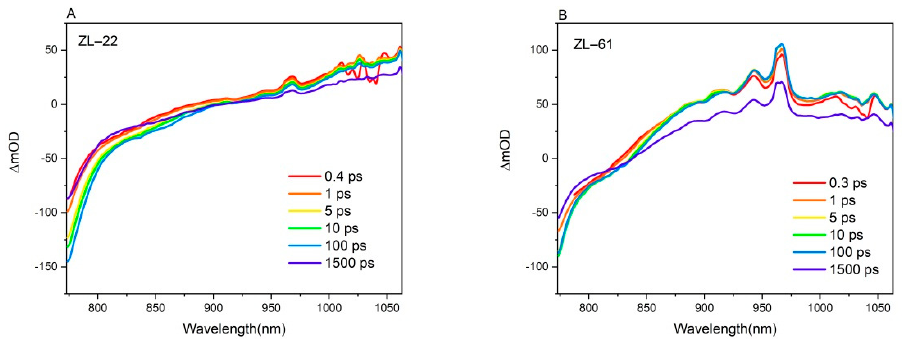
Figure 6. ( A , B ) Femtosecond TA spectra recorded at different delay times of ZL--22 and ZL--61, respectively.